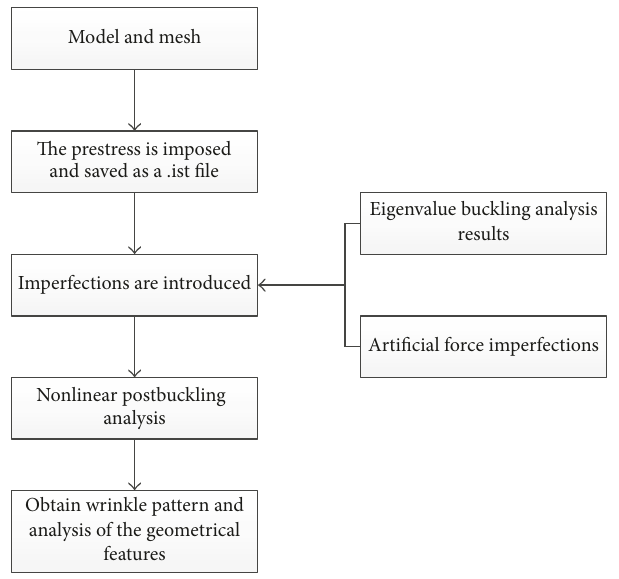
Figure 1: Flow chart for wrinkling pattern simulation.